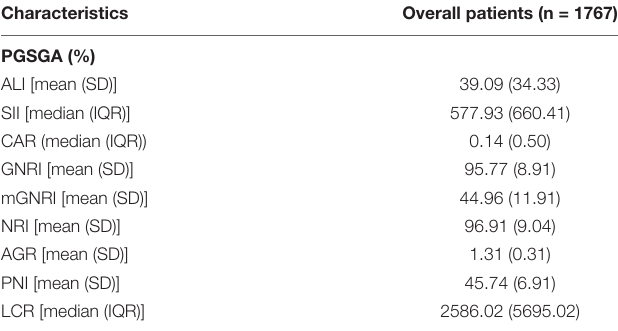
TABLE 1 | Baseline characteristics of the study population.